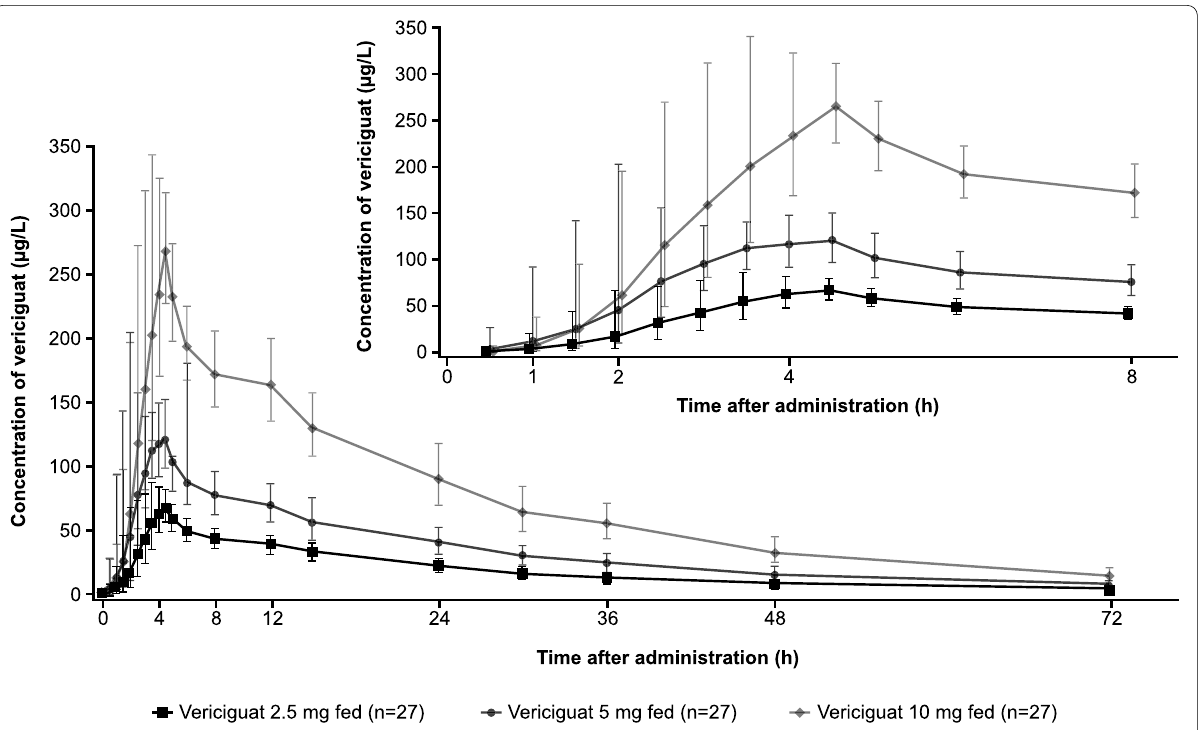
Fig. 3 Plasma concentrations of vericiguat (mg/L) after a single oral dose of vericiguat (intact tablet formulation, n